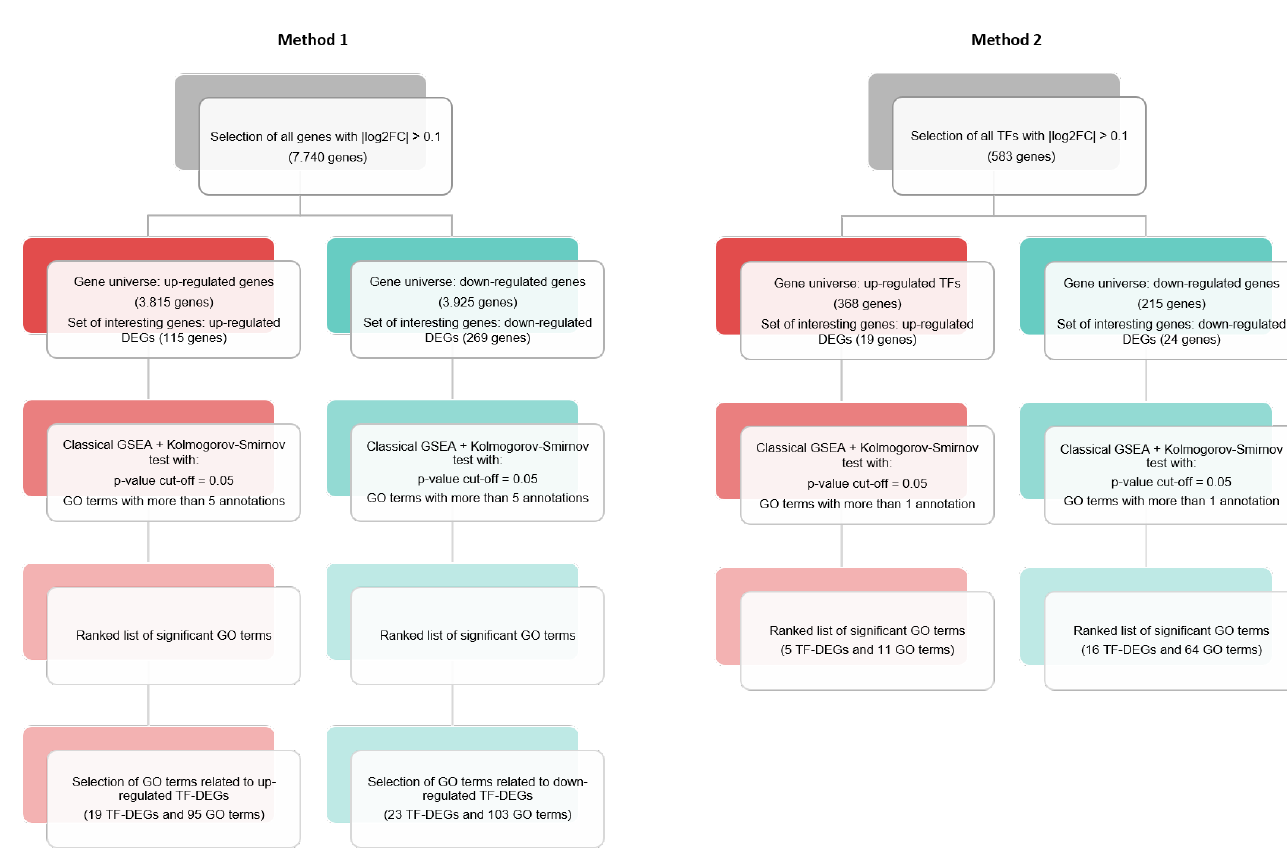
Figure 1. GSEA-based